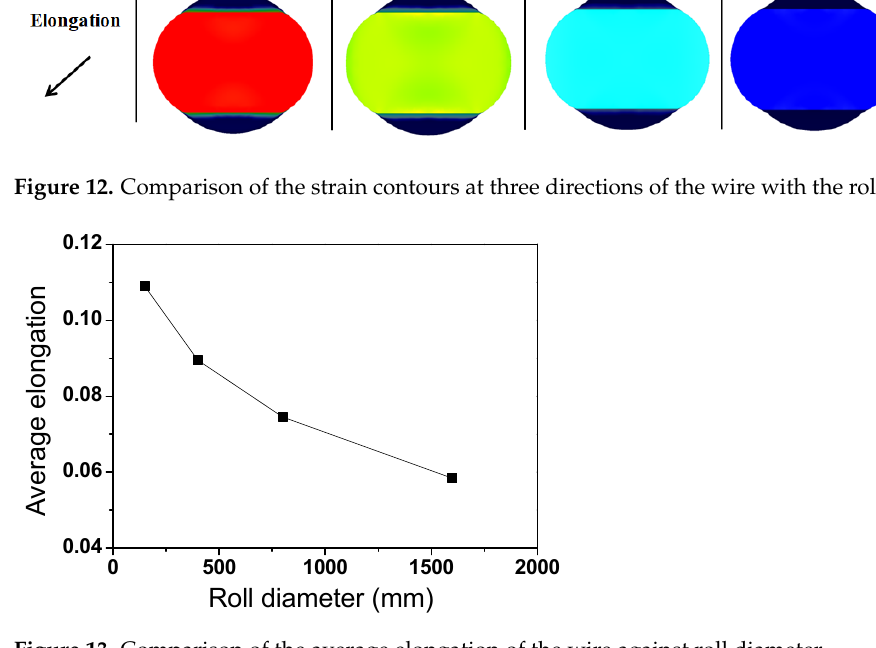
Figure 13. Comparison of the average elongation of the wire against roll diameter.